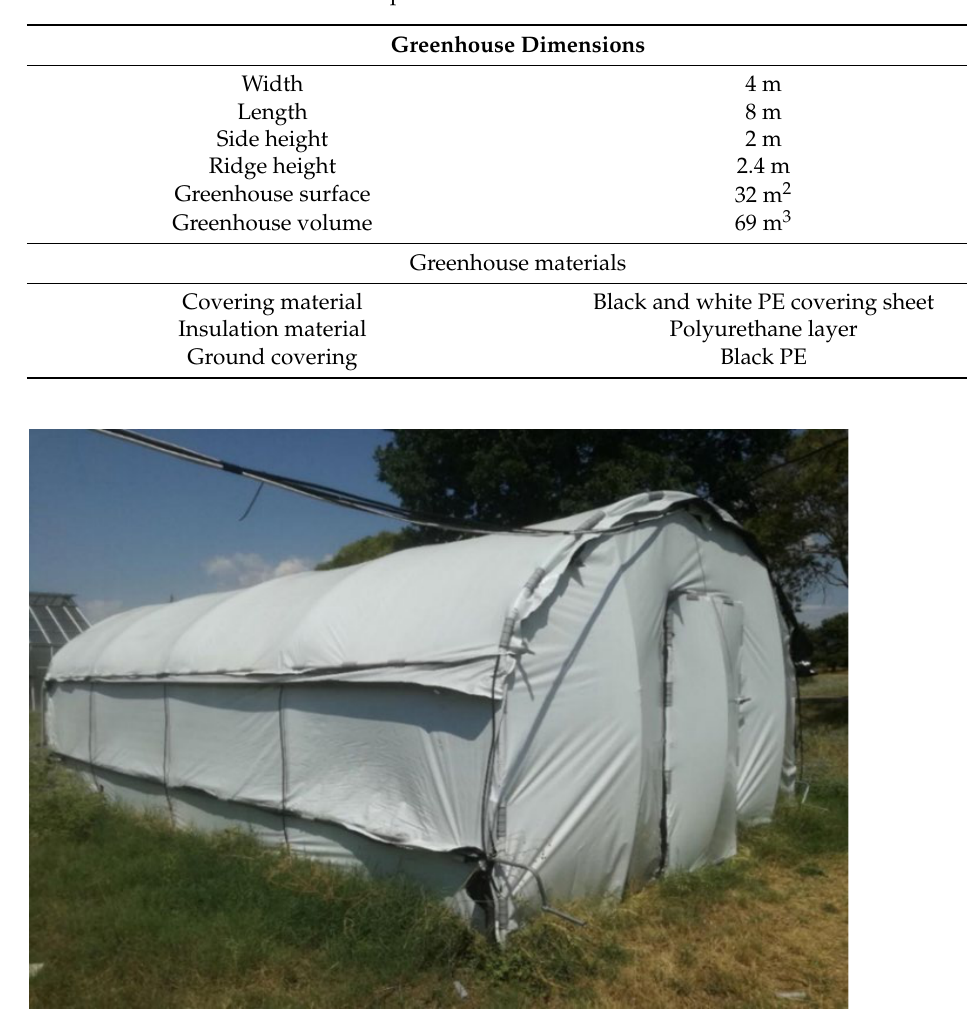
Figure 1. Greenhouse structure. Table 1. Greenhouse structure